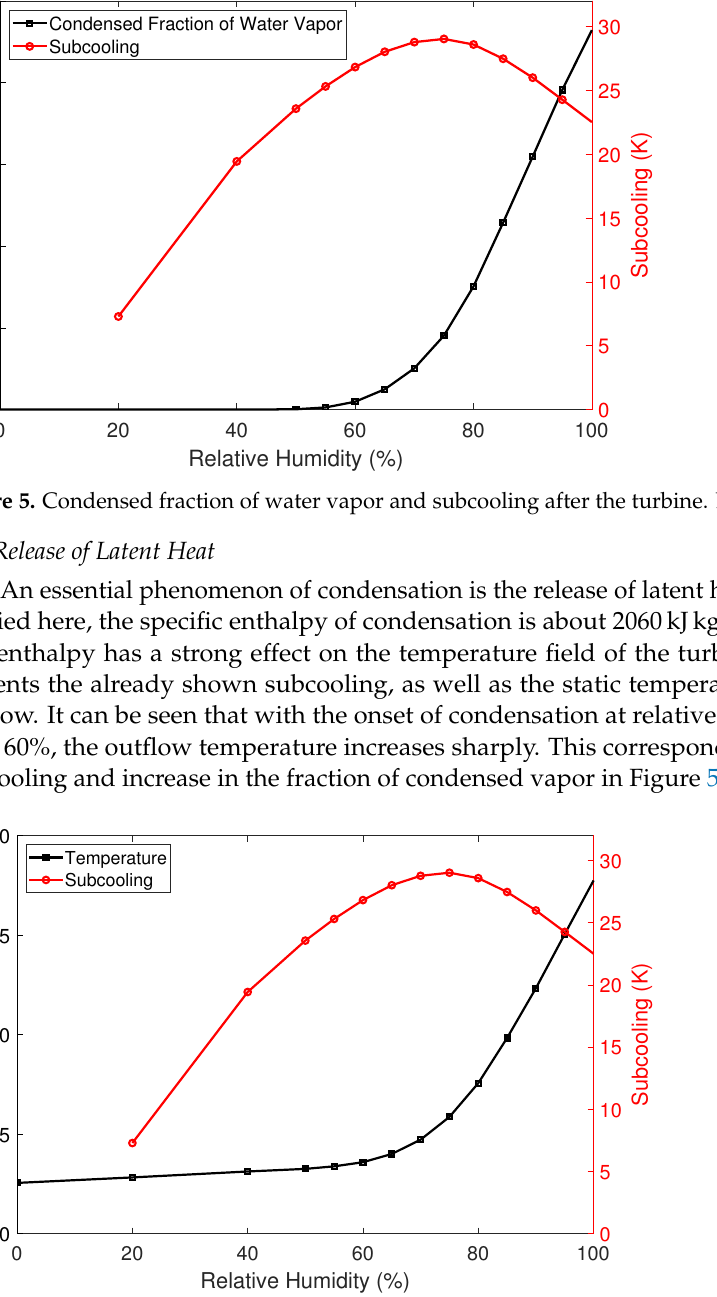
Figure 6. Static temperature and subcooling after the turbine in dependence of the relative humidity. Adapted from [12]. Copyright 2022